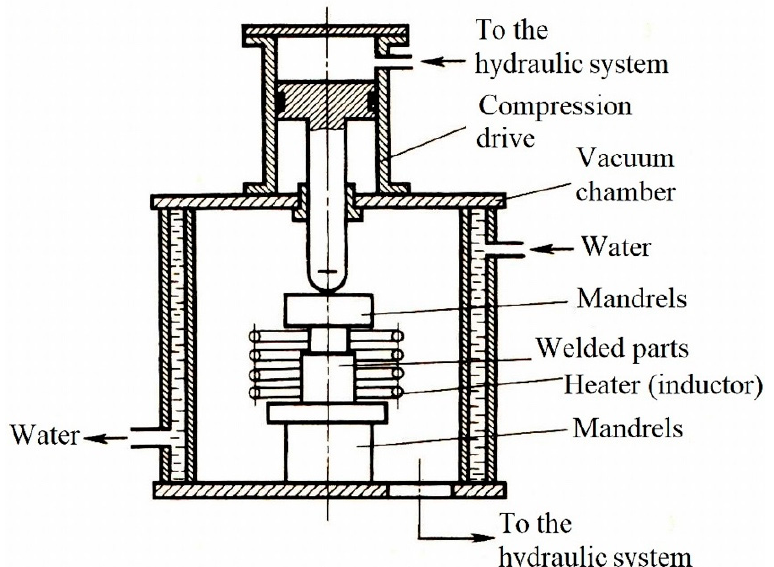
Figure 6. Diffusion welding scheme.